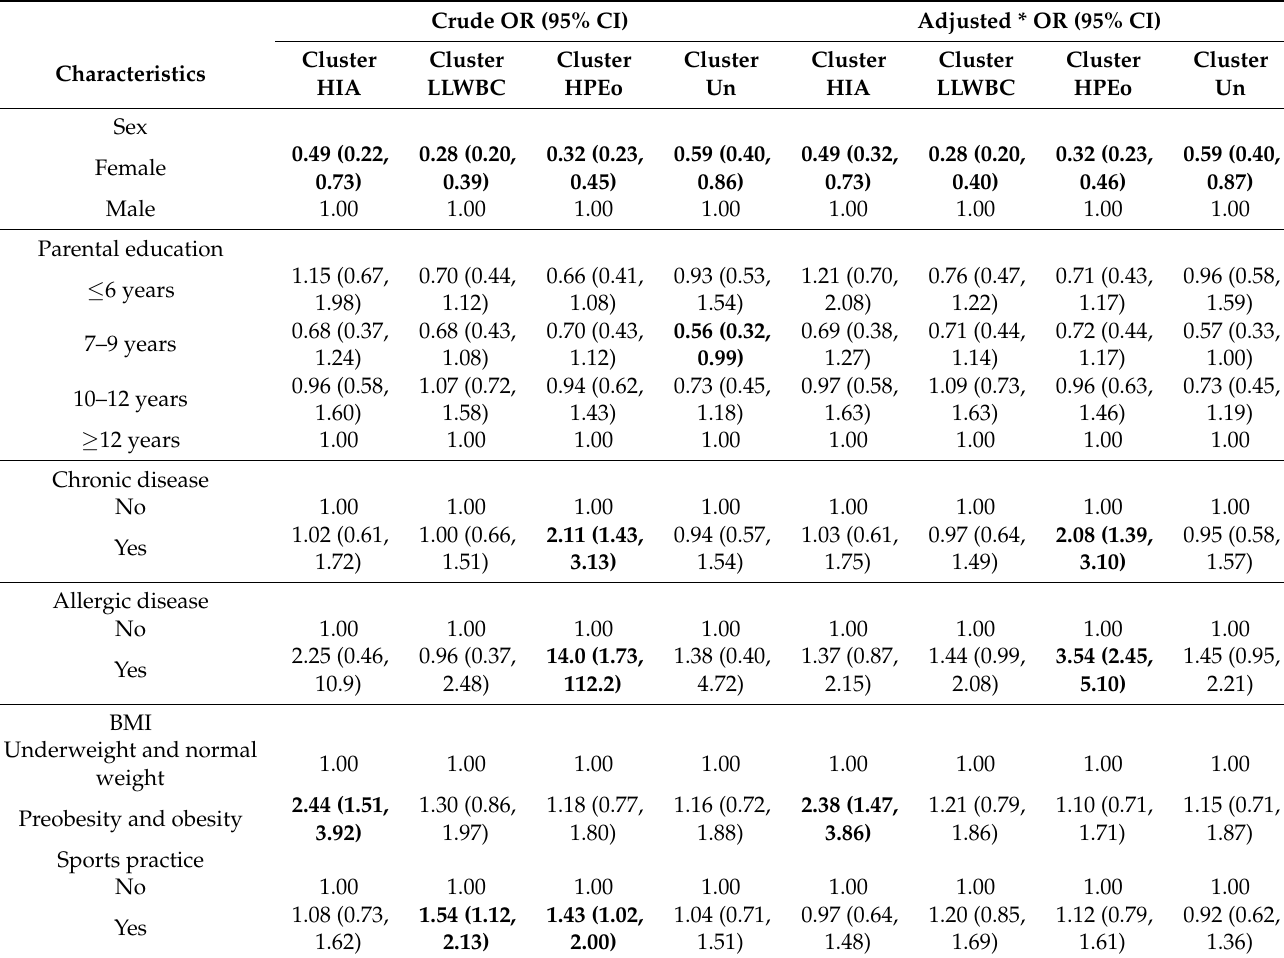
Table 3. Evaluation of social, clinical and behavioral determinants of the clusters. Crude OR (95% CI) Adjusted * OR (95%